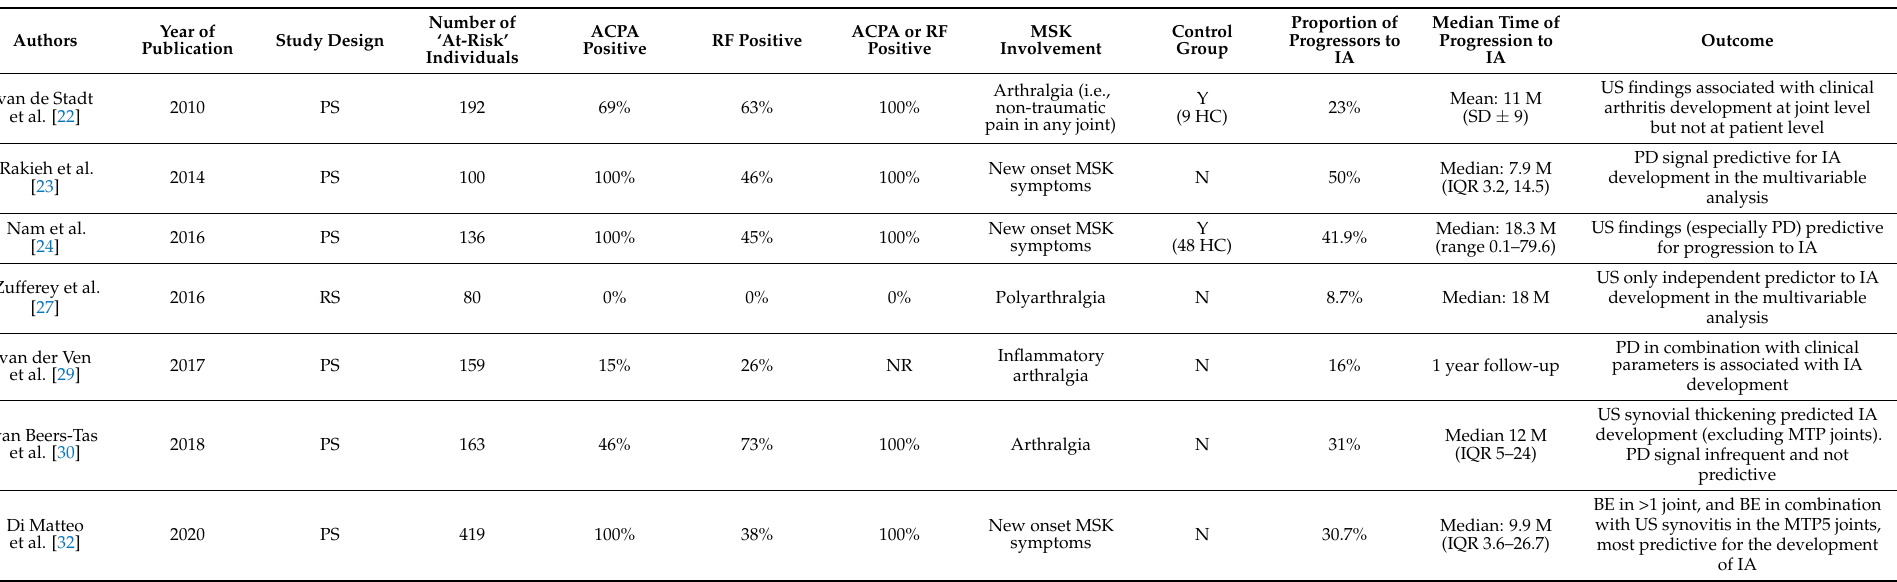
Table 1. General main characteristics of the